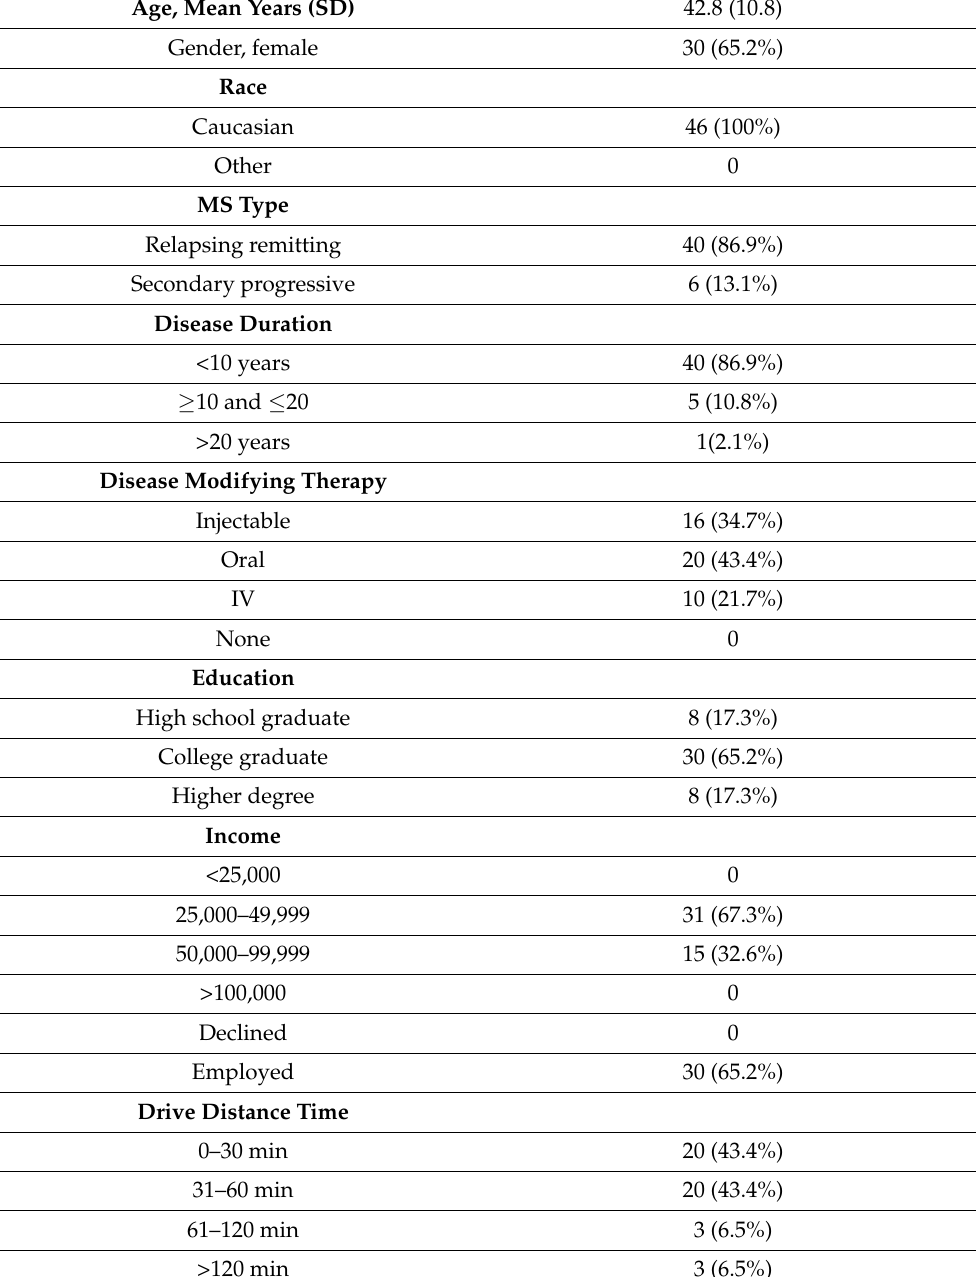
Table 1. Participant